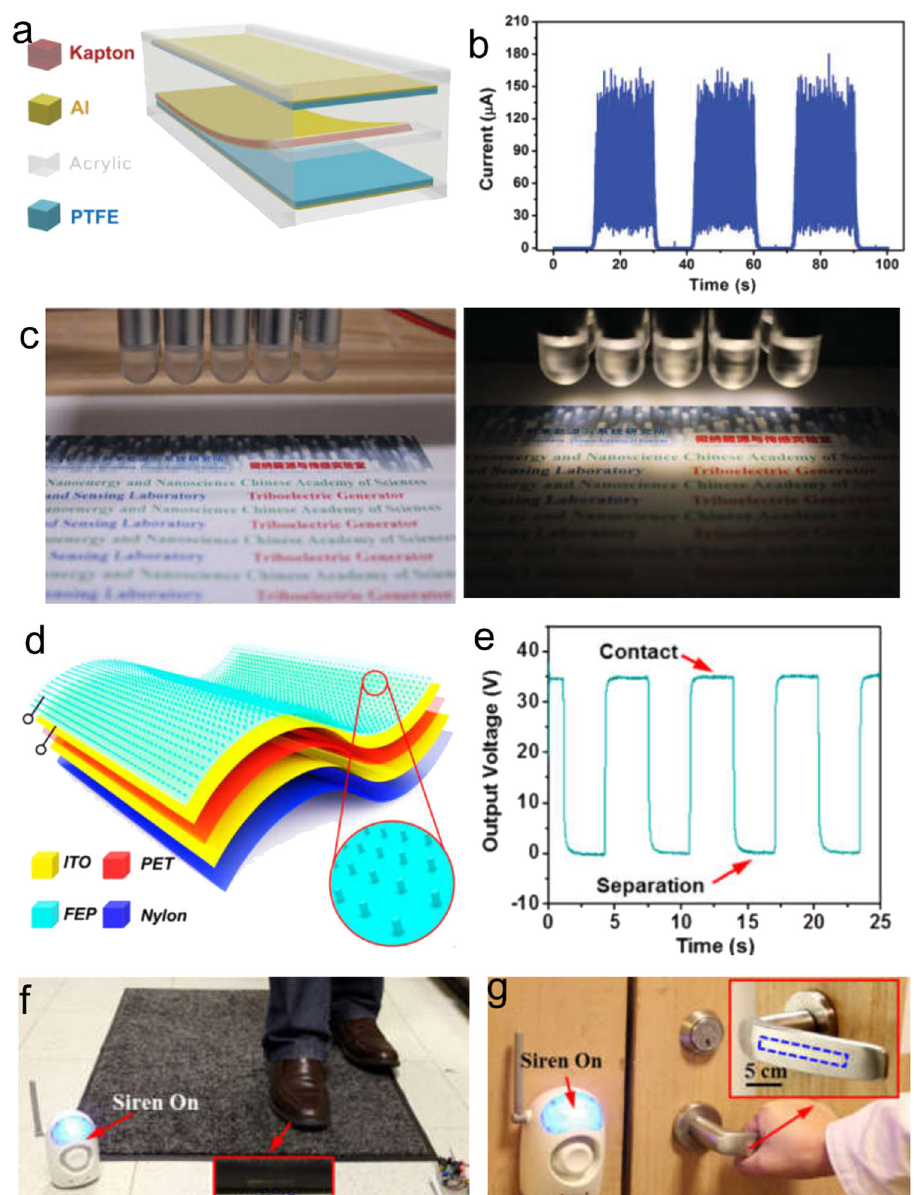
Fig. 6 a Schematic diagram of the TEG. b Output current for 10 paralleling cells. c Photographs of the LEDs were powered by 10 paralleling cells. Reproduced with permission. 35 Copyright 2011 Wiley-VCH. d Schematic diagram of the self-powered triboelectric sensor. e Output voltage at a contact force. f A photograph showing that the TES can trigger a wireless alarm when a people steps on the top of the TES. g A photograph showing that the TES triggers the alarm when it was contacted by human hand. Reproduced with permission. 36 Copyright